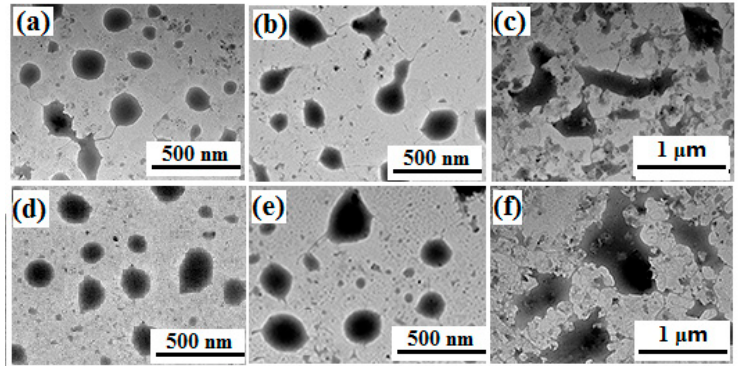
Figure 4. TEM images of the micelles formed by PNVP- b - dendr (Phe-Lys) 2 before ( a ) and after ( b ) loaded with Nile red and loaded with Nile red after the incubation with trypsin ( c ), PNVP- b - dendr (Phe-Lys) 3 , without Nile red ( d ), loaded with Nile red ( e ), and loaded with Nile red after the incubation with trypsin ( f ).